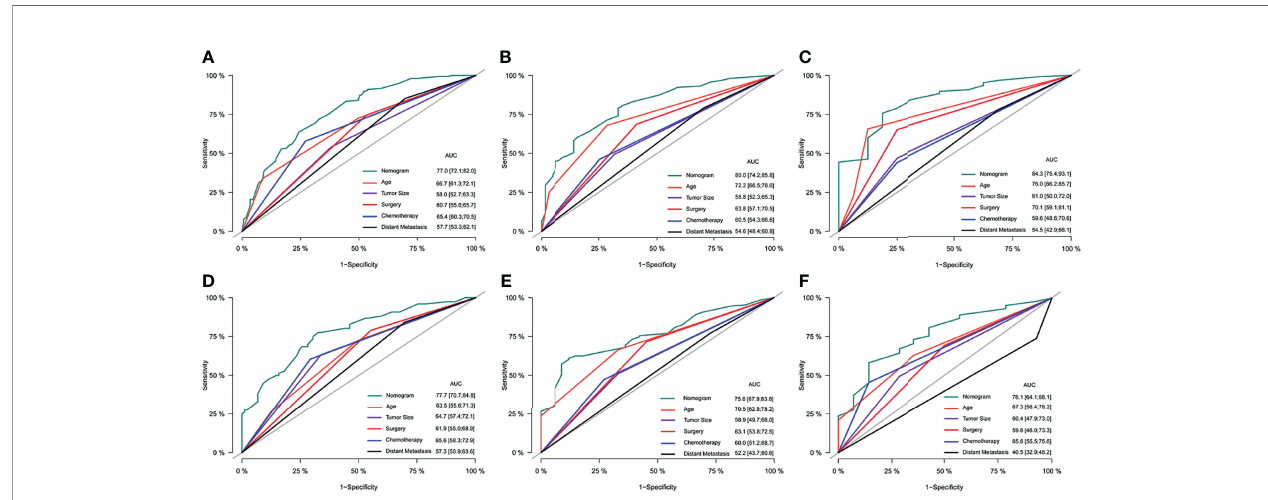
FIGURE 6 | The comparison of ROC curves of the nomogram and its constituent variables (age, tumor size, surgery, chemotherapy, and distant metastasis) for predicting 1-year (A) , 3-year (B) , and 5-year (C) OS in the training set. The comparison of ROC curves of the nomogram and its constituent variables (age, tumor size, surgery, chemotherapy, and distant metastasis) for predicting 1-year (D) , 3-year (E) , and 5-year (F) OS in the validation set. ROC, receiver operating curve; OS, Overall Survival.